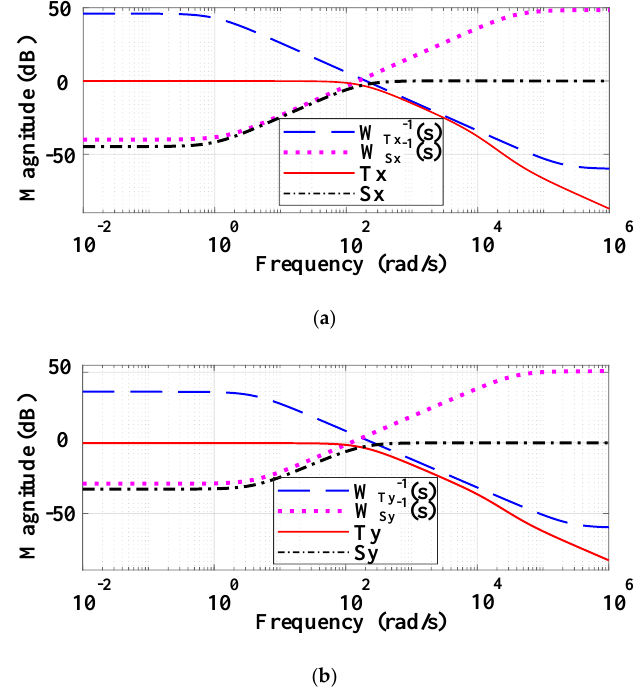
Figure 9. S/T curve. ( a ) S/T curve of X direction; ( b ) S/T curve of Y direction.